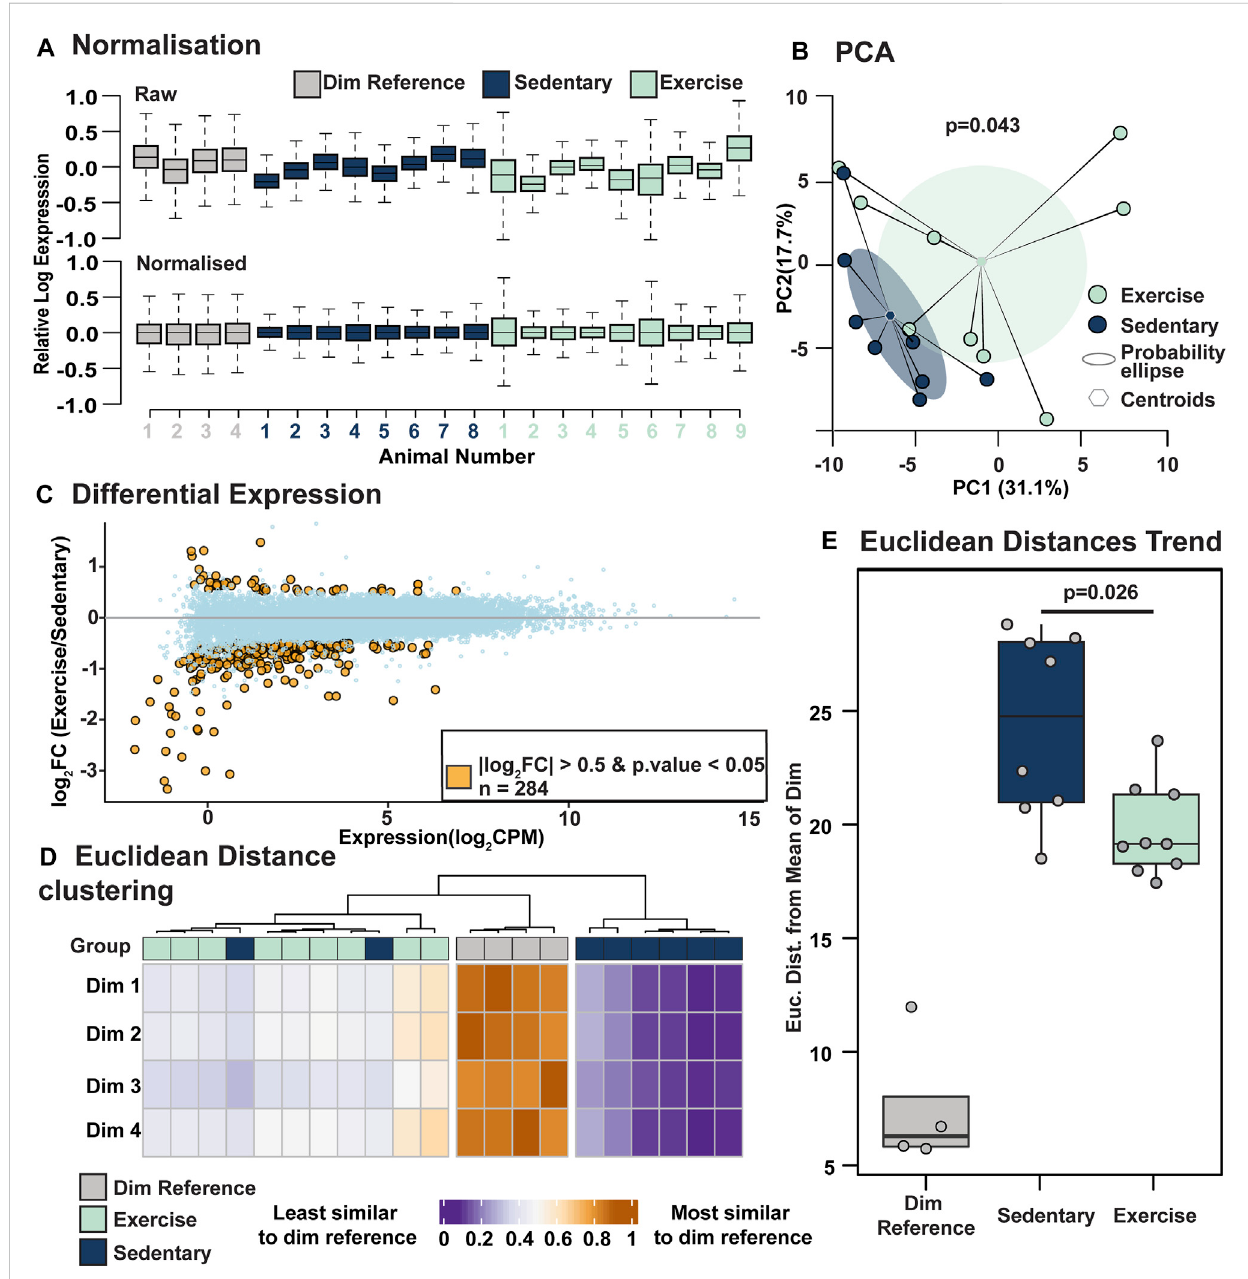
FIGURE 4 Voluntary exercise induces gene expression to a pro fi le more similar to healthy control mice. (A) Relative Log Expression plots showing effective normalisation. (B) PCA plot showing signi fi cant clustering of the exercise and control groups. p -values were derived by performing env fi t analysis on the PCA object with 10 6 permutations. Shaded area represents the probability ellipse of each group calculated by using the group standard deviation and a con fi dence limit of 0.95. (C) Volcano plot showing differentially expressed genes between exercised and sedentary retinas (absolute Log2FC > 0.5, p < 0.05 ). (D) Clustering of Euclidean distances calculated using expression values of differentially expressed genes. Distances for both exercise and sedentary groups were calculated relative to a reference matrix containing expression values of differentially expressed genes (exercise vs. sedentary) in heathy dim-reared retinas. This heatmap indicates that the expression values of the 284 differentially expressed genes trend more strongly towards heathy controls (dim-reared mice) values in exercised mice than in sedentary mice. (E) Summary of Euclidean distances between exercise and sedentary mice relative to dim-reared mice based on the 284 differentially expressed genes in (C) . Signi fi cance tested using Wilcoxon signed-rank test. n = 4-9